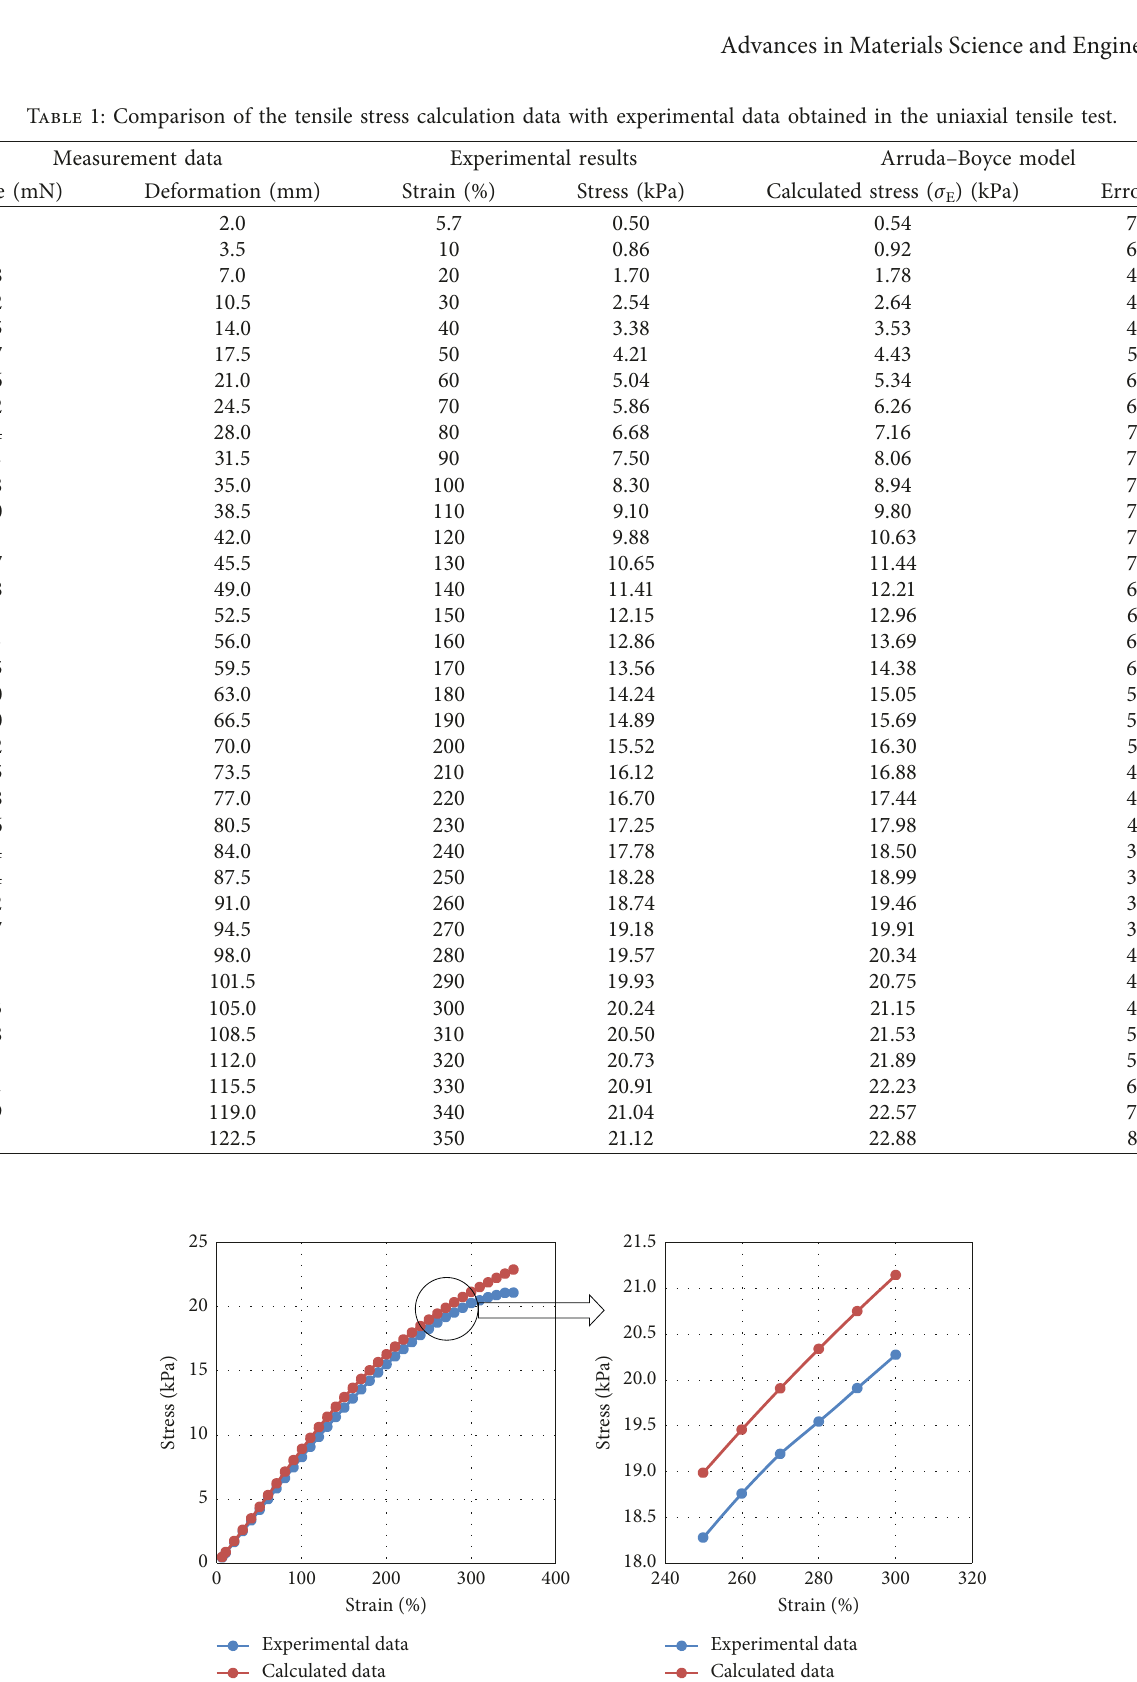
Figure 12: Comparison of the tensile stress calculation data with experimental data obtained in the uniaxial tensile